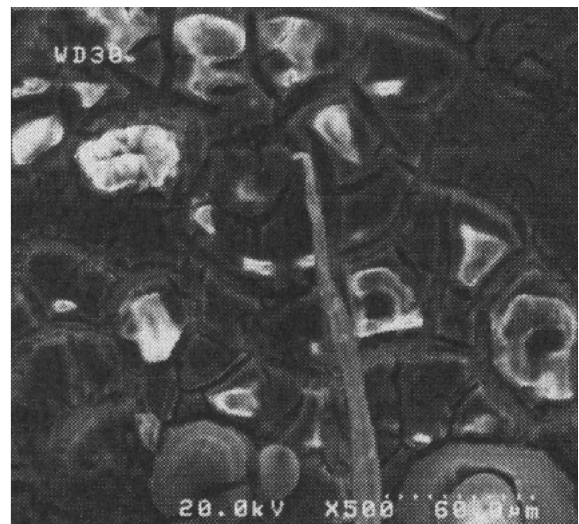
Figure 17. Macroscopic image of oxide layers in sample